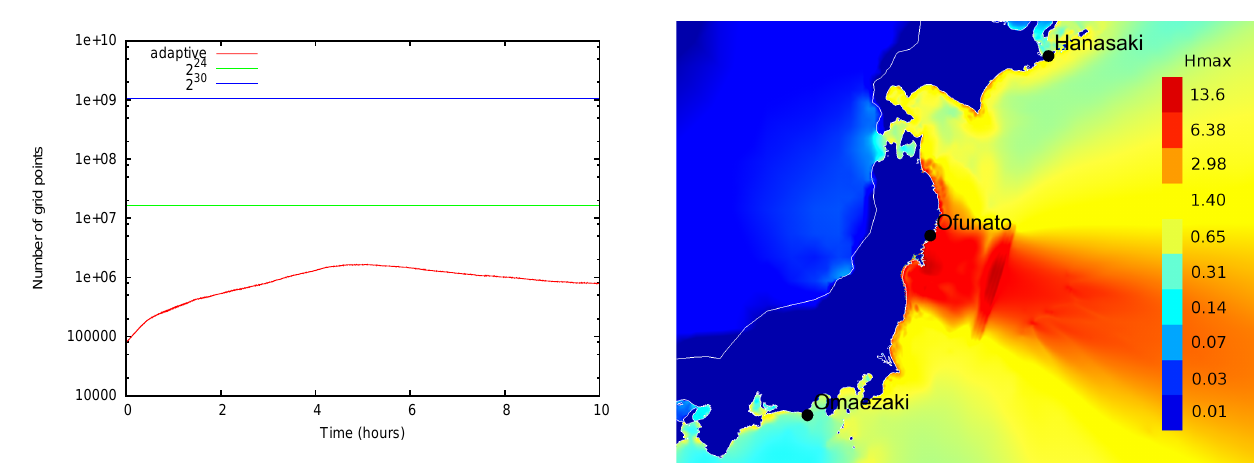
Fig. 10. Detail of the maximum wave elevation reached over 10h. The (logarithmic) colorbar gives the maximum wave elevation in metres. The model predict maximum wave elevations of more than 40m on the coast of the Oshika peninsula (south of